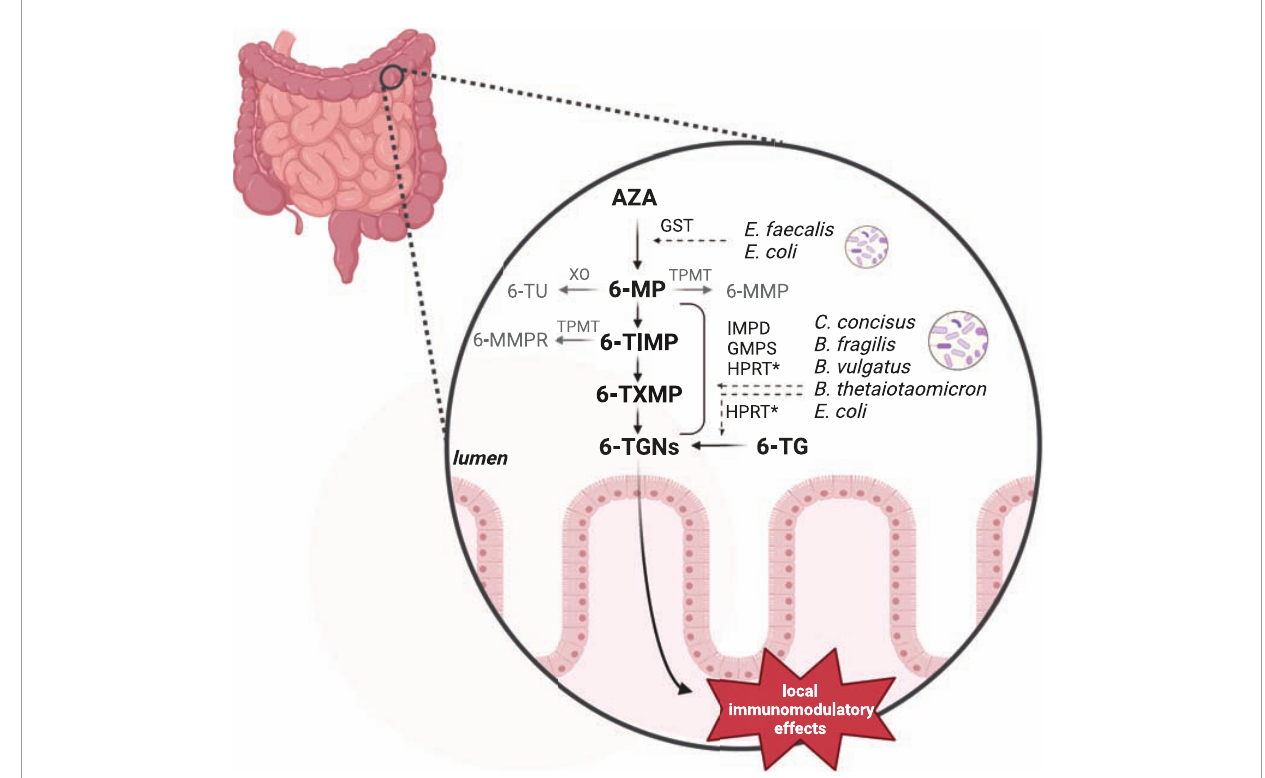
FIGURE2 Bacterial thiopurine conversion. Azathioprine (AZA) and 6-mercaptopurine (6-MP) can be converted by microbial enzymes into the anti-inflammatory 6-tioguanine nucleotides (6-TGNs). In vitro studies observed different enzymatic processes and the responsible genes by a number of intestinal bacteria, including Enterococcus faecalis , Escherichia coli , Campylobacter concisus , Bacteroides fragilis , Bacteroides vulgatus , and Bacteroides thetaiotaomicron . Not all of these species contained all of the required enzymes to individually catalyze the complete pathway. GST, glutathione S-transferase; HPRT, hypoxanthine guanine phosphoribosyl transferase; IMPD, inosine monophosphate dehydrogenase; GMPS, guanosine monophosphate synthetase. Hprt has not been detected in C. concisus by Liu et al. (2017). Created with